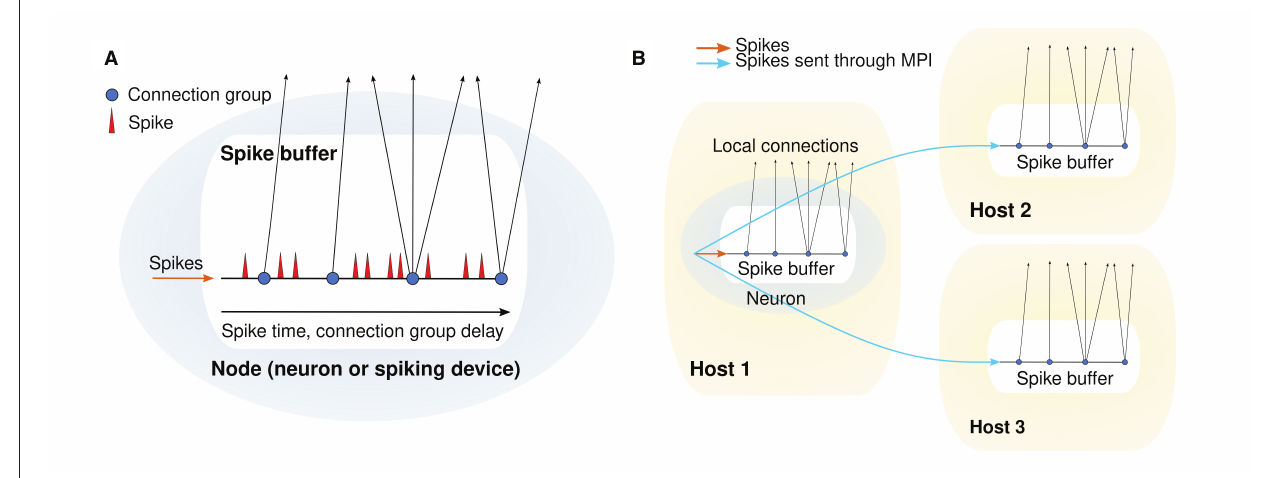
FIGURE 1 | Spike handling and delivery schemes. (A) Structure of a single spike buffer. (B) Schematic depicting MPI communication between spike buffers for different hosts.